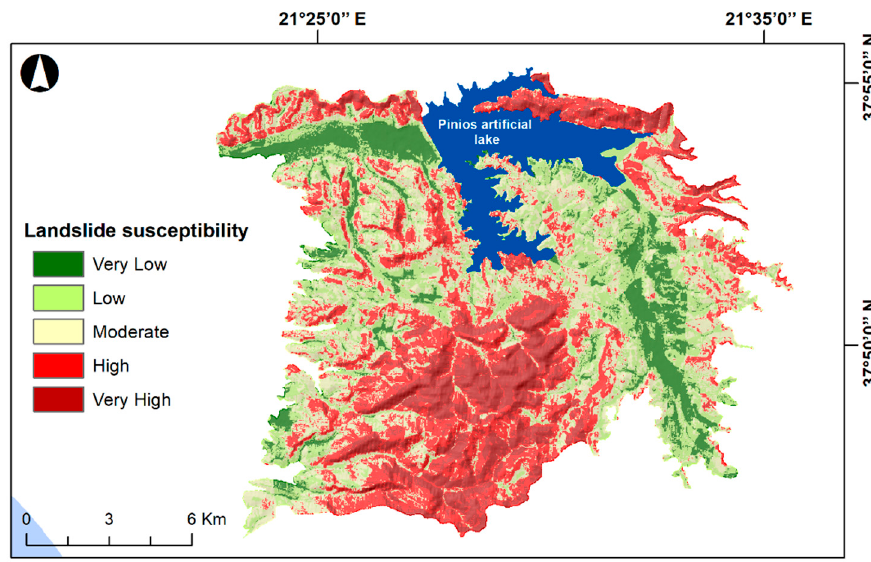
Figure 7. The landslide susceptibility map produced by the individual IV model.